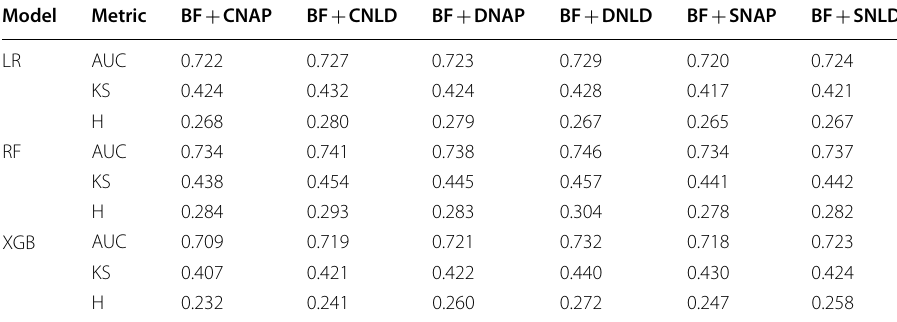
Table 39 Discrimination performance of different feature sets